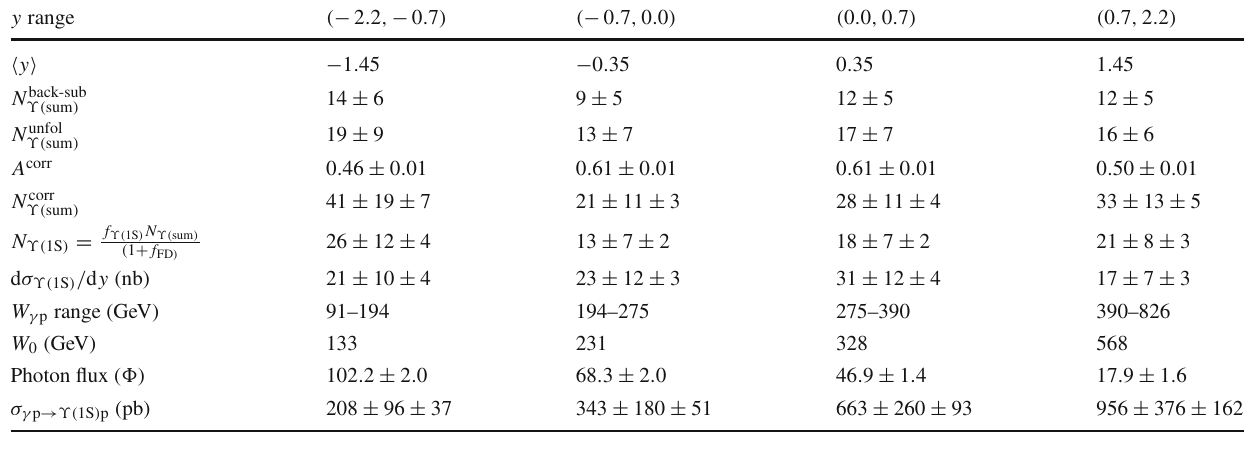
Fig. 6 Cross section for exclusive ϒ( 1S